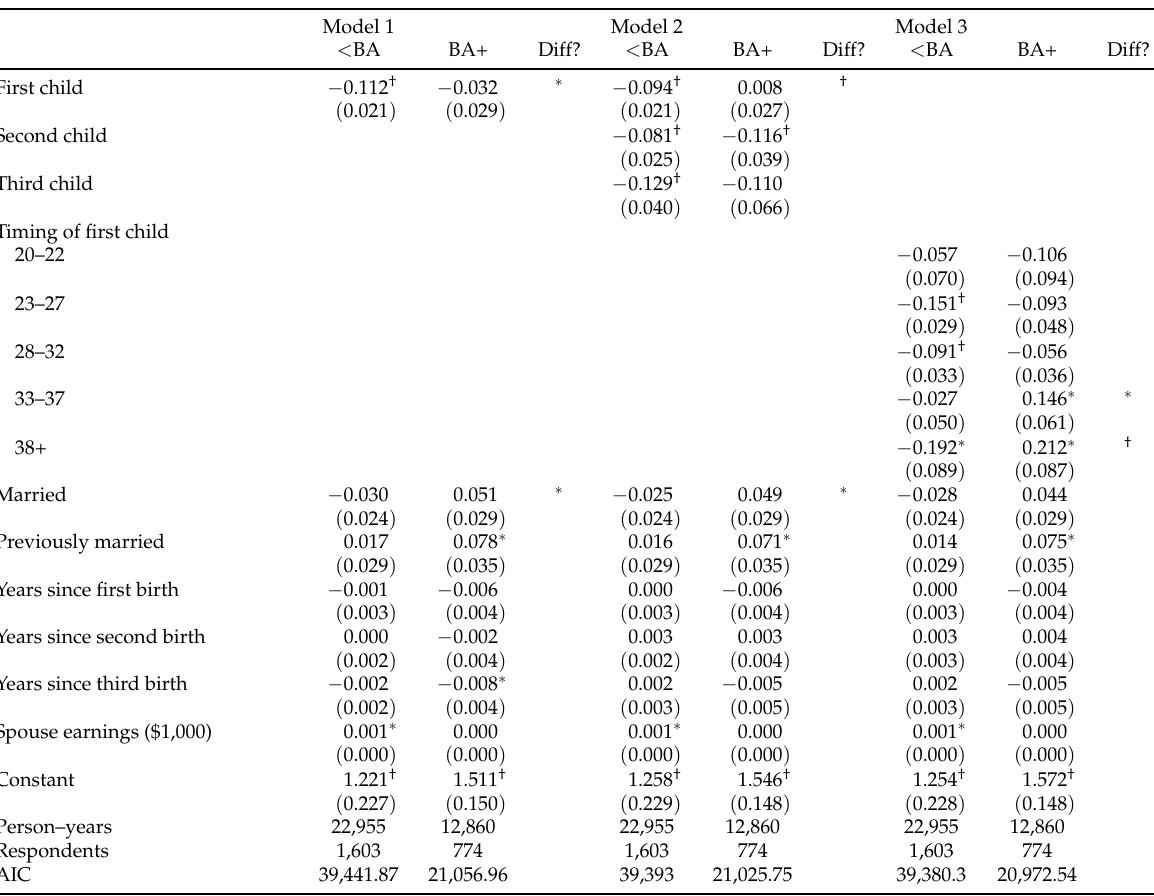
Table 3: Fixed-effects estimates of motherhood, parity, and timing on log wages by education with family